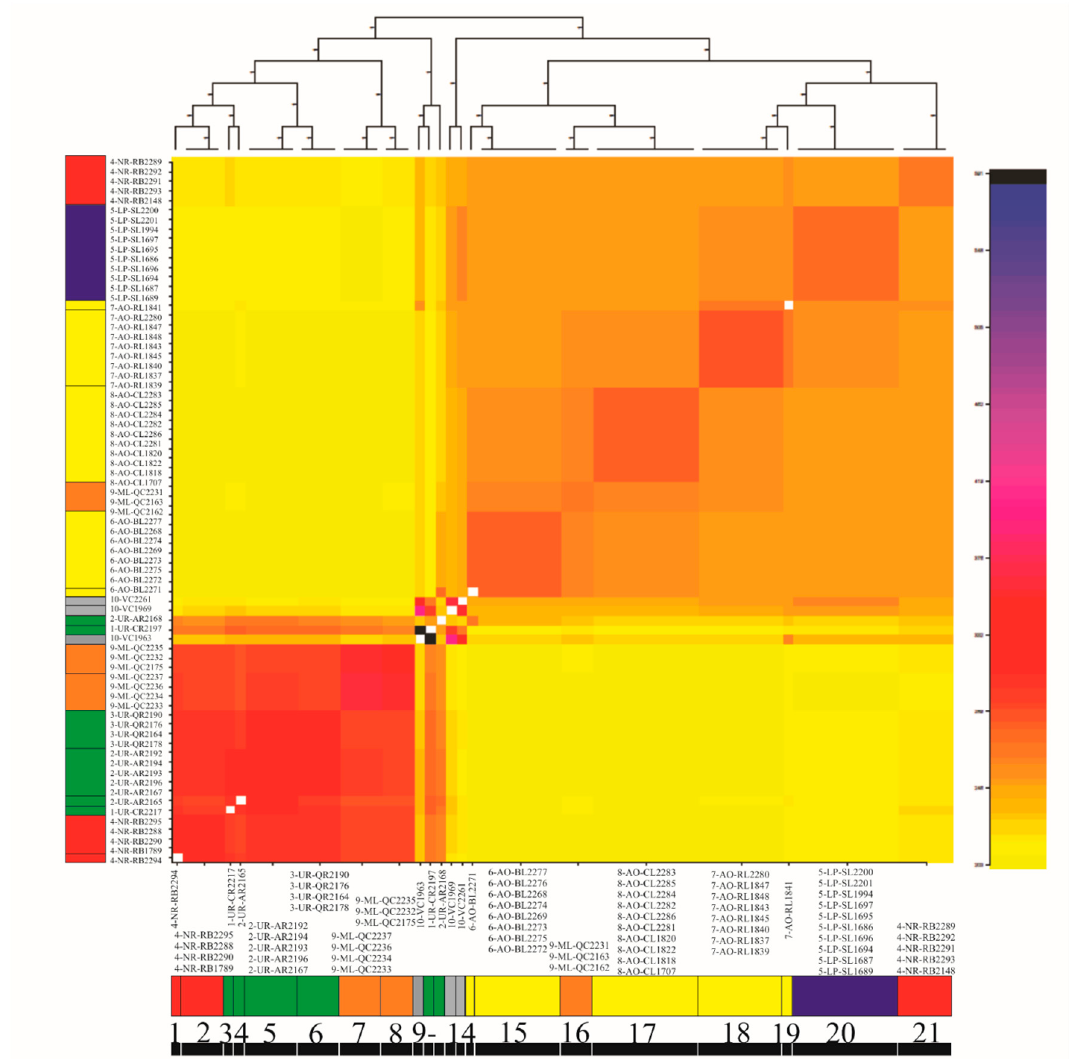
Figure 4. Rhamdia quelen fineRADstructure plot based on Total loci . The horizontal axis shows clusters of individuals and the vertical axis shows each individual. Pairwise coefficients of co-ancestry are color-coded from low (yellow) to high (black). The dendrogram shows a clustering of individual samples based on the pairwise matrix of co-ancestry coefficients. Legends on the left and below the co-ancestry matrix show the name of each individual, and their corresponding basins are colored according to the code used in Figure 1 (Uruguay River basin: green; Negro River basin: red; La Plata River basin: blue; coastal SW Atlantic Ocean basin: yellow; Merin lagoon: orange). Numbers along the bottom line indicate the different minor clusters detected.